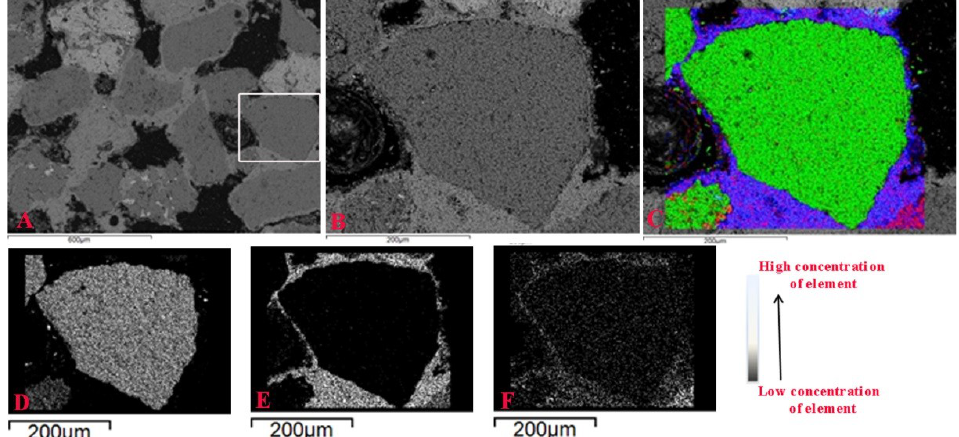
Figure 15. ( A ): BSE-SEM image indicating textural characteristics of beachrocks of area 2; ( B ): Selected micro region of Figure 15A for elemental mapping of Si, Ca, and Mg. It is indicating the cement phase around a quartz grain; ( C ): Distribution of Si (green), Ca (blue), and Mg (red); ( D ): Distribution of Si (white); ( E ): Distribution of Ca (white), and ( F ): Distribution of Mg (white). Note the magnesium participation in the cement phase, but in lower concentrations compared to the calcium one.